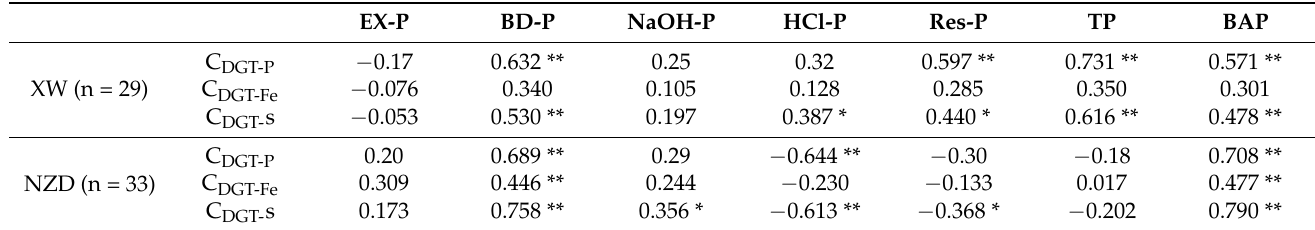
Table 3. The correlation analysis of P fractions and the C DGT-P , C DGT-Fe , C DGT-S